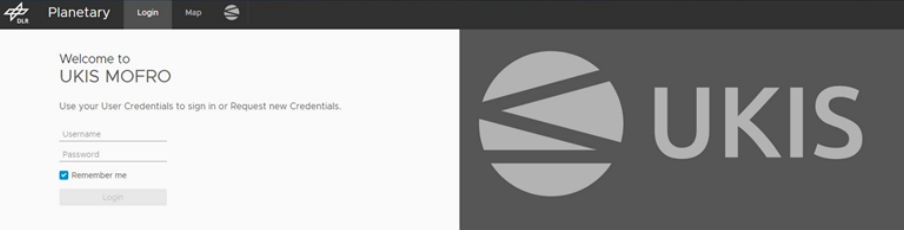
Figure 8. Login GUI for the